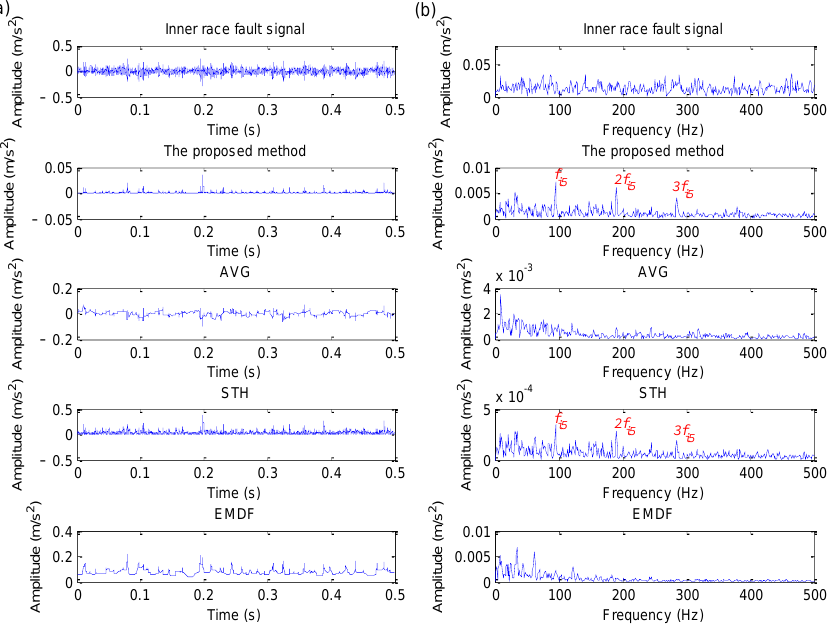
Figure 25. Analysis results obtained by different methods for inner race fault signal in case 3: ( a ) Time domain waveform; ( b ) its corresponding envelope spectrum.